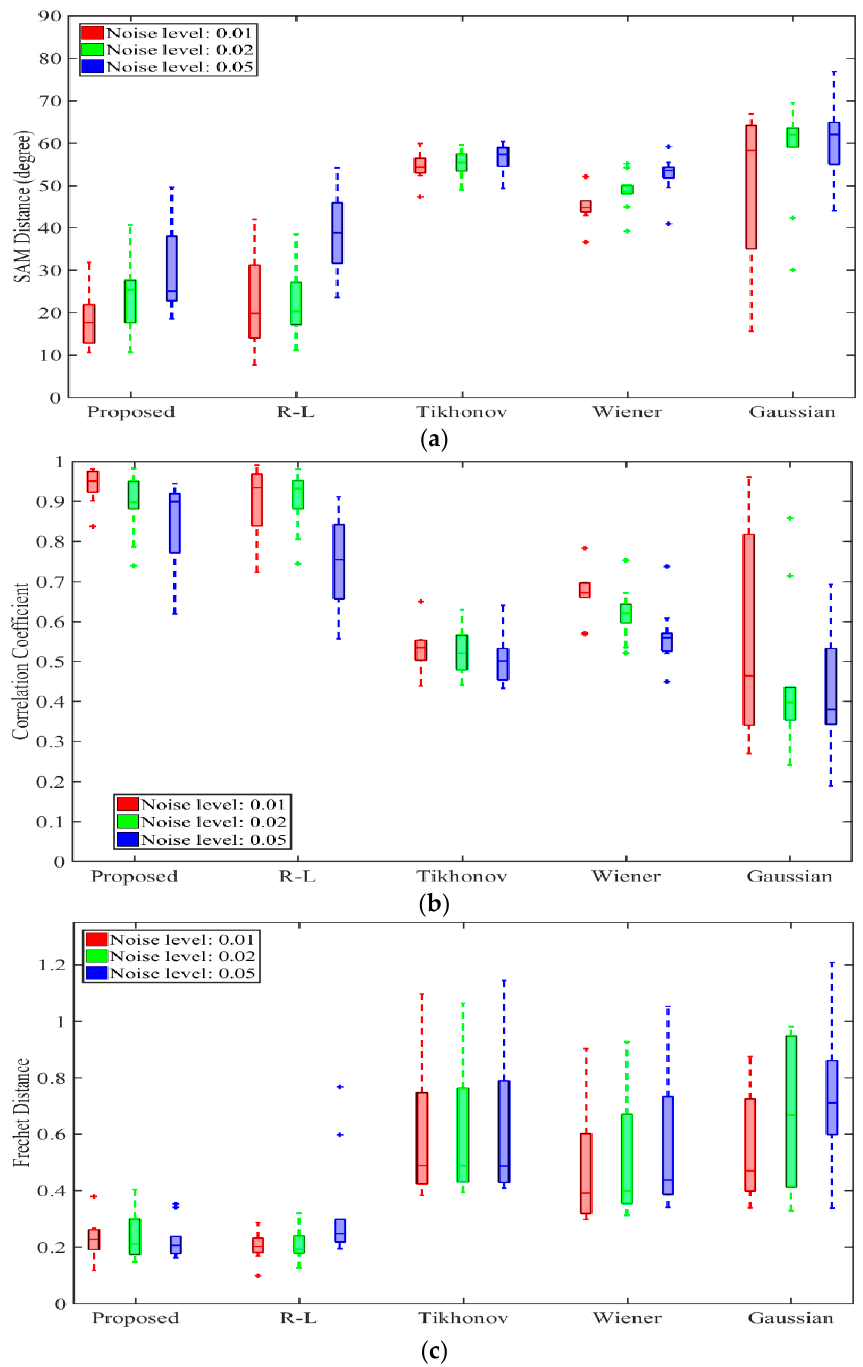
Figure 5. Comparison of the proposed method with others at different noise levels in terms of the three different metrics: ( a ) SAM distance; ( b ) Correlation Coefficient and ( c ) Fréchet distance.